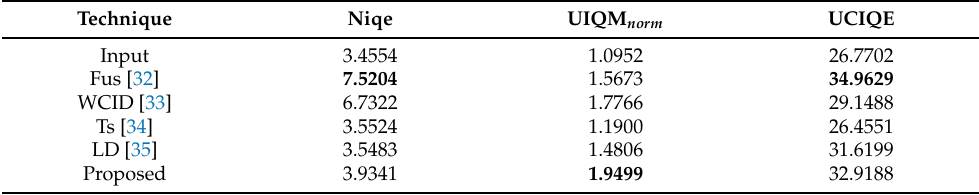
Table 3. Average niqe, UIQM norm , UCIQE comparison of different techniques whose results are partially presented in Figure 7. The best result is